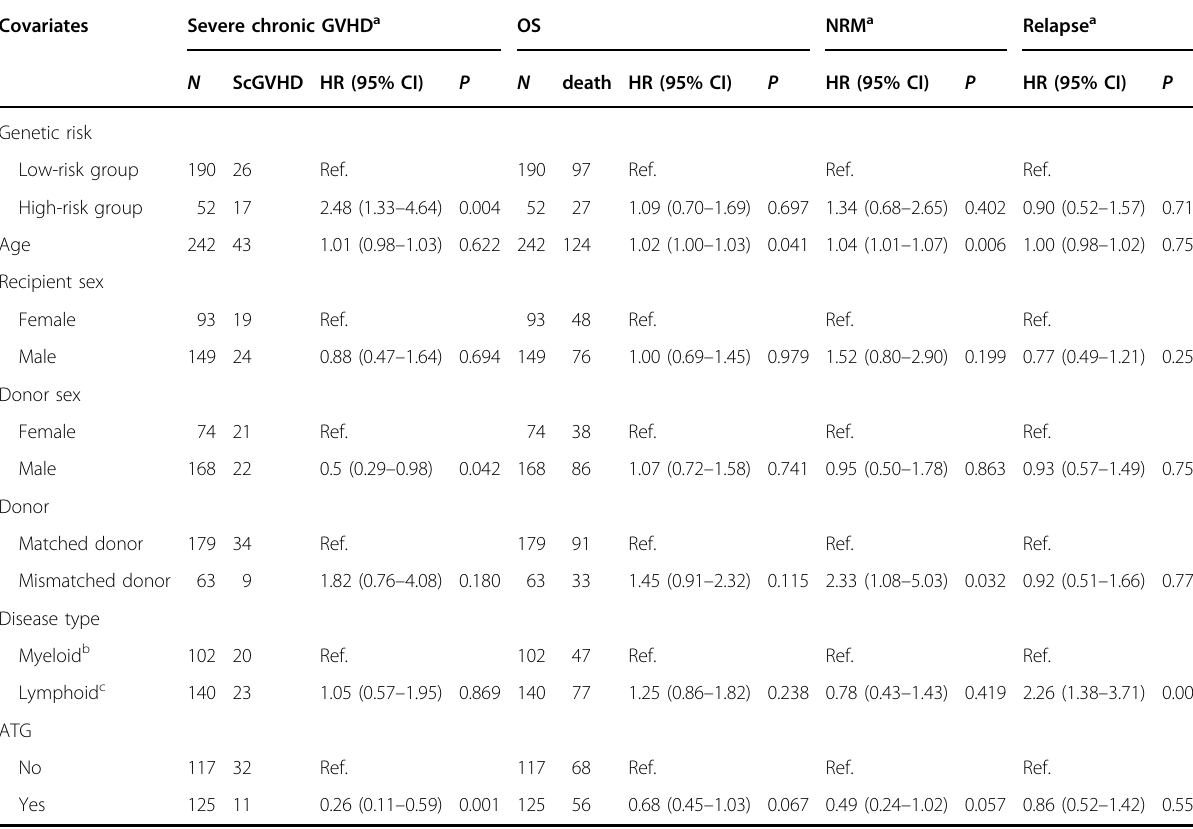
Table 2 Multivariable analysis of the incidence of severe cGVHD, OS, NRM, and relapse in the training cohort. Covariates Severe chronic GVHD a